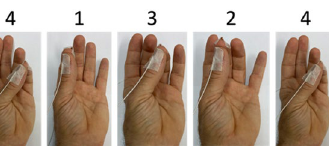
Figure 7. The sequence of finger-to-the thumb opposition movements (4–1–3–2–4) that participants were required to perform (from left to right) throughout the experiment. During tests the participants were instructed to perform the sequence repeatedly as “fast and as accurate” as they can during a 30 s interval. During training the participants of the Fixed control and Variable groups were following an auditory guide (set of rhythmic beeps) for the timing of the within-sequence movements, while the participants of the Unsupervised control group had an auditory cue only for the start of the sequence. The wires shown are the Ascension trakSTAR sensors used to measure the 3D location of the